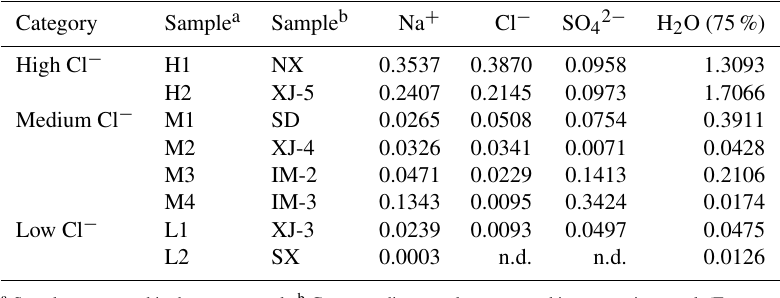
Table 1. Overview of mass fractions of major soluble ions and mass ratios of particulate water at 75% ± 2% RH to dry particles for the eight saline mineral dust samples examined in this work. Mass fractions of major soluble ions were reported previously (Tang et al., 2019), and particulate water contents at 75% ± 2% RH were measured by the present work. The abbreviation n.d. denotes not detected.